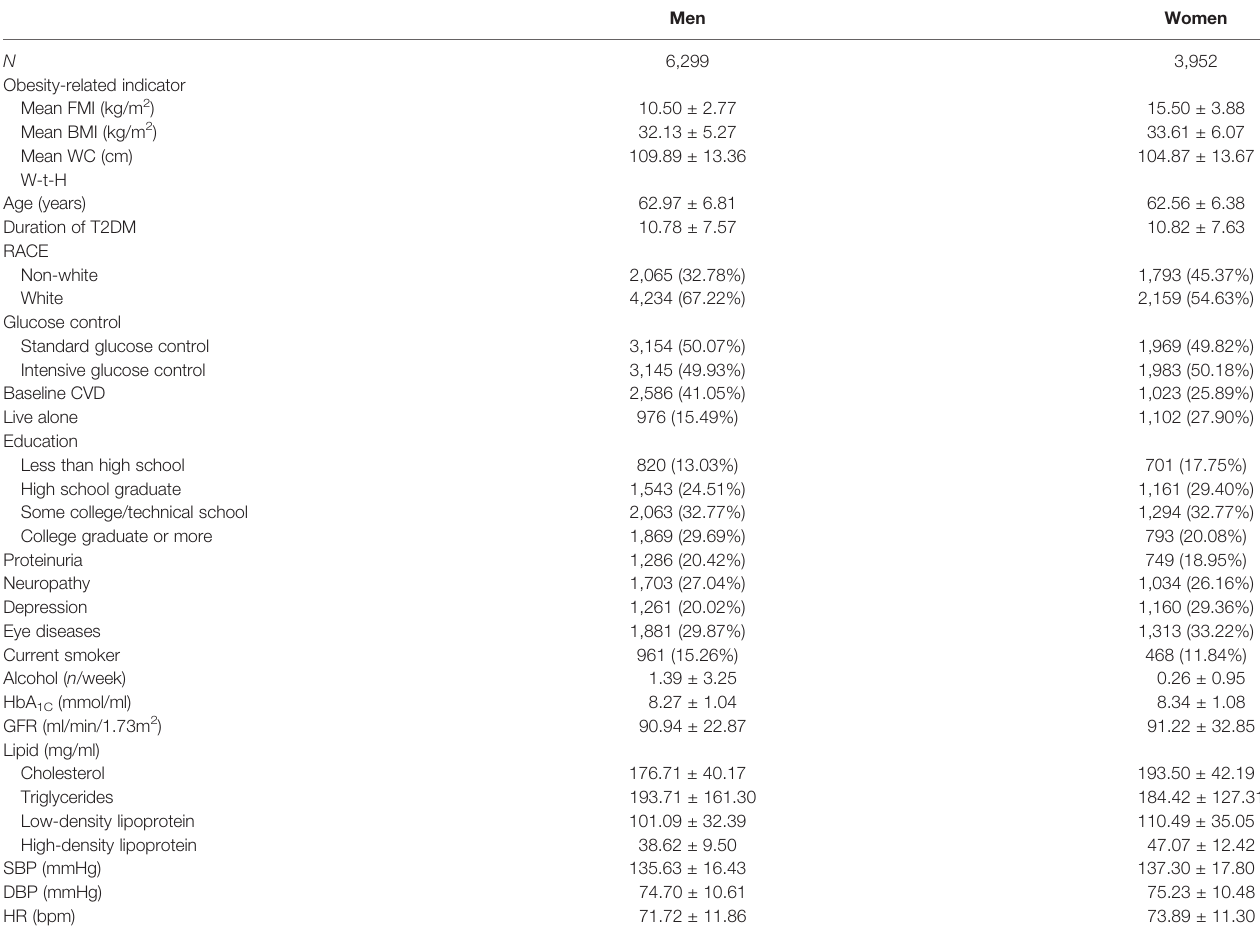
TABLE 2 | Baseline characteristics of patients with